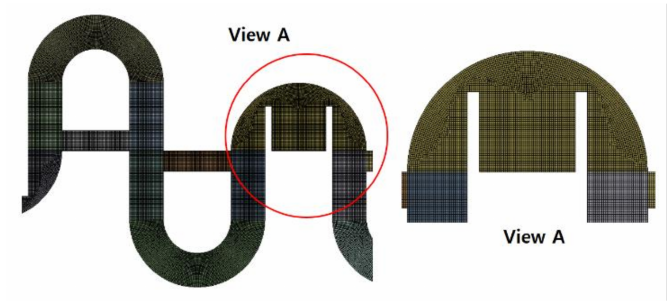
Figure 7. Enlarged frontal view of grid.